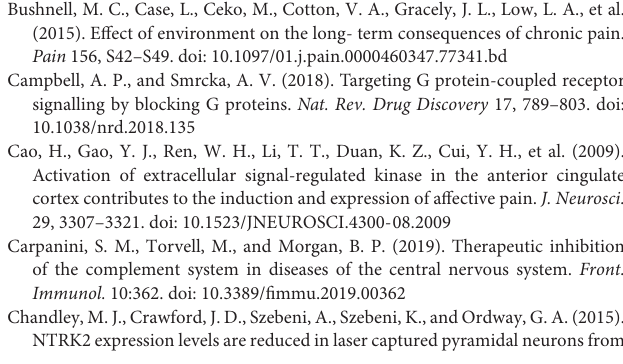
the Row Z-score among the different datasets. The up- and down-regulated genes are colored in red and green, respectively. Supplementary Figure 3 | Heatmaps of the representative differentially expressed genes (DEGs) in the AMY after nerve injury. Top 15 up- and down-regulated G protein-coupled receptor mRNAs (A) , ion channel mRNAs (B) , and lncRNAs (C) in the AMY on day 7 after SNL. Colors in the heatmaps indicate the Row Z-score among the different datasets. The up- and down-regulated genes are colored in red and green, respectively. Supplementary Figure 4 | The common biological processes and KEGG pathways in the SC, ACC and AMY after nerve injury. (A-D) The top 10 common enrichments in biological processes (blue panels on the left) and KEGG pathways (red panels on the right) between SC and ACC (A) , SC and AMY (B) , or ACC and AMY (C) . The top 10 common function enrichments in biological processes (blue panels on the left) and KEGG pathways (red panels on the right) among SC, ACC and AMY (D) according to the P -value. Blue and red bars represent the biological process and pathway enrichments, respectively. Supplementary Figure 5 | Heatmaps of the identified pain-, anxiety- and depression-related genes in the SC, ACC and AMY after nerve injury. (A) Heatmaps of 157 (100 upregulated and 57 downregulated) pain-, 220 (140 upregulated and 80 downregulated) anxiety- and 278 (176 upregulated and 102 downregulated) depression-related DEGs in the ACC. (B) Heatmaps of 149 (100 upregulated and 49 downregulated) pain-, 201 (146 upregulated and 55 downregulated) anxiety- and 287 (207 upregulated and 80 downregulated) depression-related DEGs in the AMY; C, Heatmaps of 230 (196 upregulated and 34 downregulated) pain-related DEGs in the spinal cord. Colors in the heatmaps indicate the Row Z-score among the different datasets. The up- and down-regulated genes are colored in red and green, respectively. Supplementary Figure 6 | The functional prediction of DE lncRNAs by GO and KEGG analyses in the ACC from SNL mice. (A-C) Directed Acyclic Graphs (DAGs) graphically display the significant GO enrichment results with the candidate targeted genes in biological process (A) , molecular function (B) , and cellular component (C) . (D) The significant molecular function, biological process and cellular component enrichment analysis of DE lncRNA-related mRNAs. (E,F) The DE lncRNA-related mRNAs enriched KEGG pathways represented by enrichment scores ( − log10 ( P -value)) (E) and the scatterplot showing statistics of pathway enrichment (F) , respectively. The color of pathway terms is defined by the enrichment P -value. Supplementary Figure 7 | The functional prediction of DE lncRNAs by GO and KEGG analyses in the AMY from SNL mice. (A-C) Directed Acyclic Graphs (DAGs) graphically display the significant GO enrichment results with the candidate targeted genes in biological process (A) , molecular function (B) , and cellular component (C) . (D) The significant molecular function, biological process and cellular component enrichment analysis of DE lncRNA-related mRNAs. (E,F) The DE lncRNA-related mRNAs enriched KEGG pathways represented by enrichment scores ( − log10 ( P -value)) (E) and the scatterplot showing statistics of pathway enrichment (F) , respectively. The color of pathway terms is defined by the enrichment P